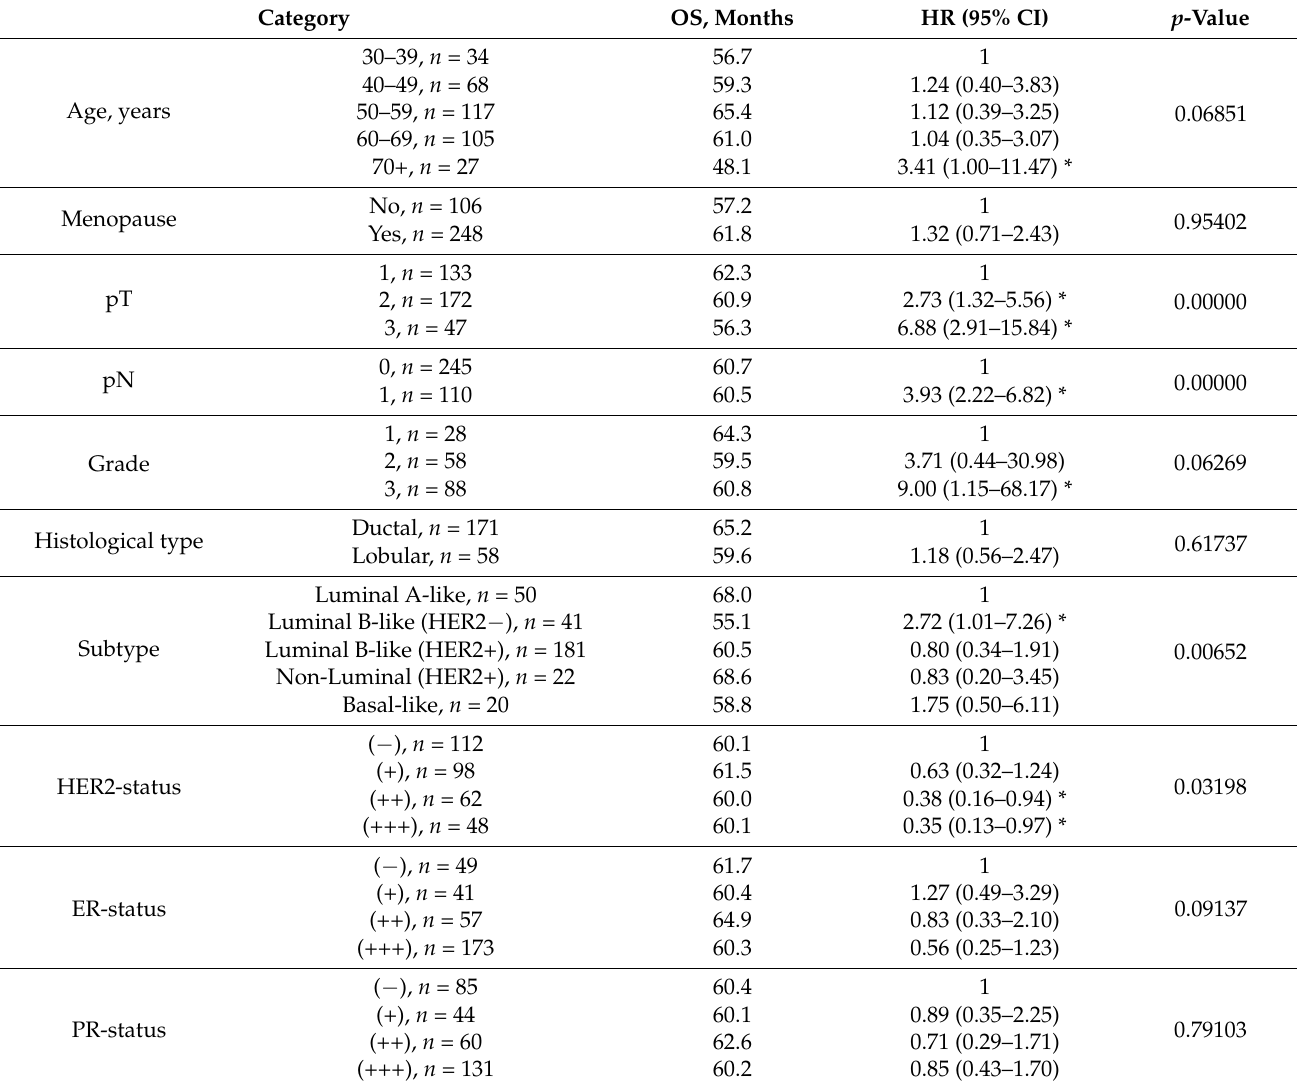
Table 1. Overall survival rates depending on the clinicopathological characteristics of patients.